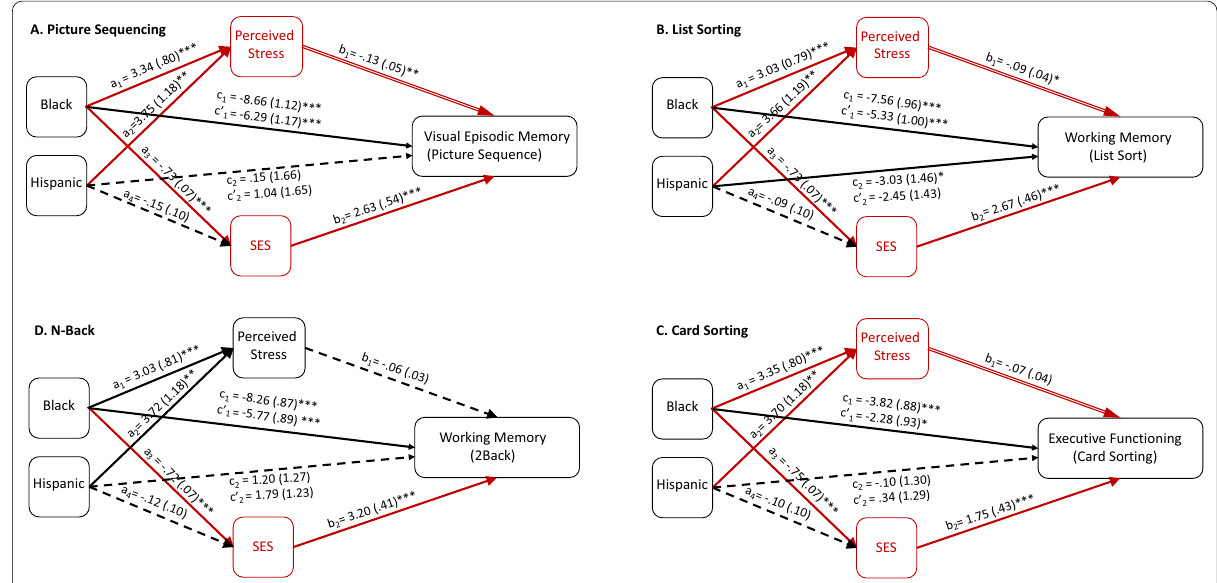
Fig. 3 Parallel mediation analyses for picture sequencing ( A ), list sorting ( B ), card sorting ( C ), and the N‑Back ( D ). Perceived stress predicted ethnoracial disparities in cognition for the picture sequence task and the list sorting task, but not the other two. SES predicted ethnoracial disparities in cognition for all four cognitive tasks. Unstandardized parameter estimates and standard errors are shown for each pathway. Asterisks denote significant pathways for one ethnoracial minority with a single line and for both ethnoracial minorities with a double line: * ** p < .01, *** p < .001. Dashed lines represent non‑significant pathways. Red lines and text represent significant mediating = =